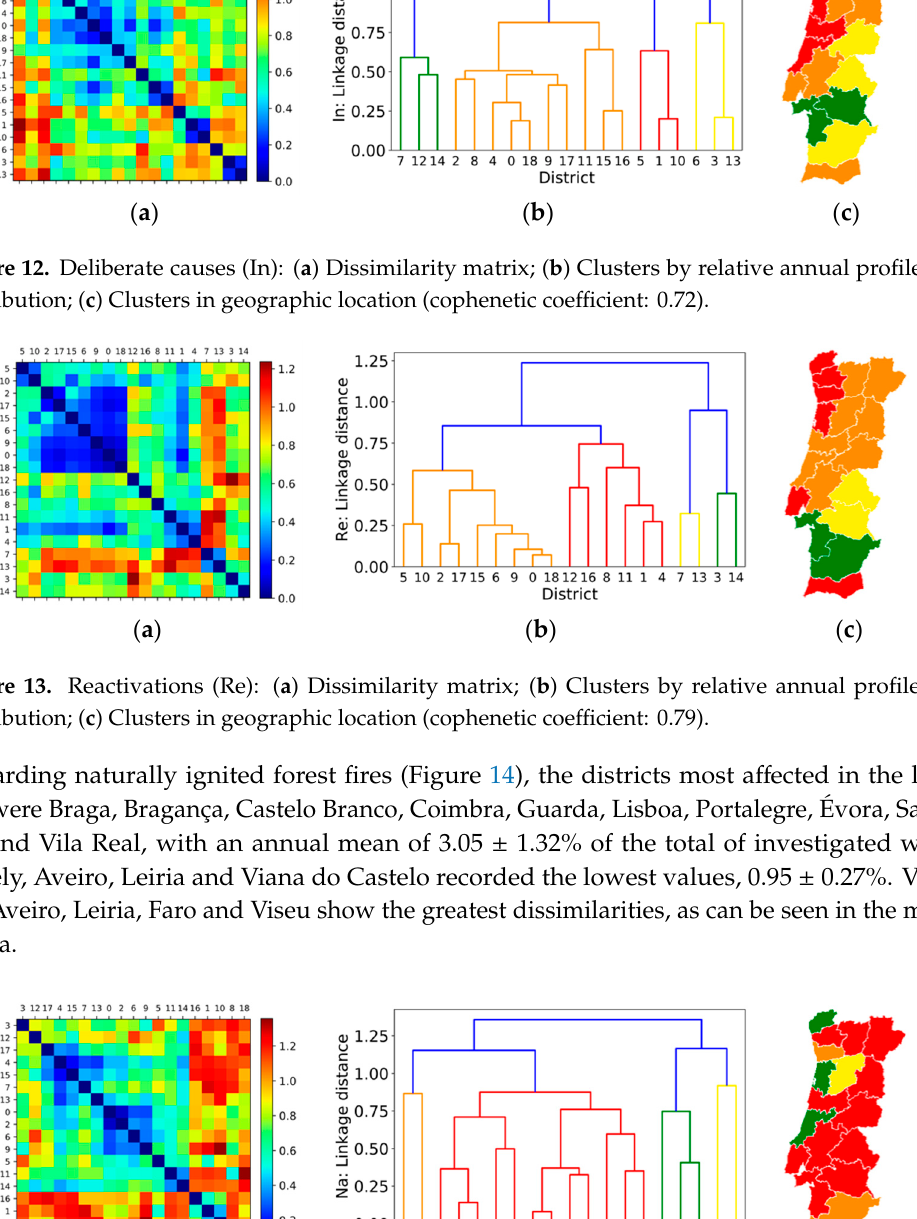
Figure 12. Deliberate causes (In): ( a ) Dissimilarity matrix; ( b ) Clusters by relative annual profile of distribution; ( c ) Clusters in geographic location (cophenetic coefficient: 0.72).